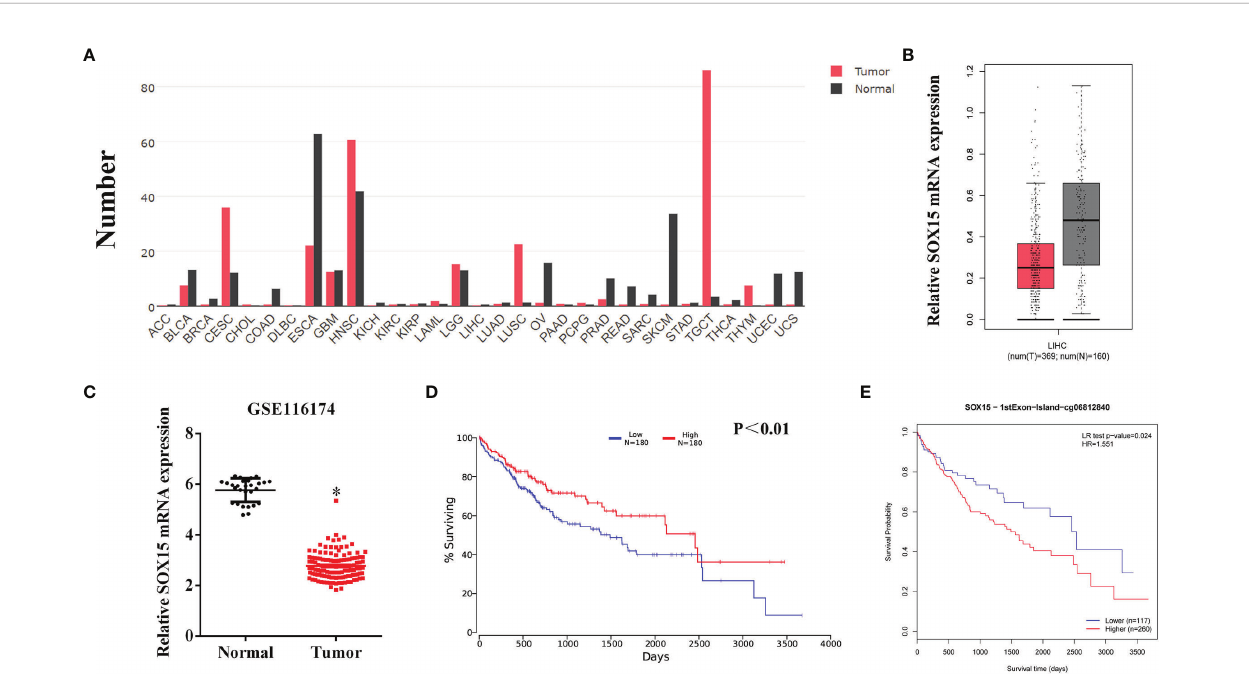
FIGURE 1 | The expression of Sox15 is reduced and positively correlates with prognosis in HCC as analyzed by TCGA and GEO data. (A) Expression pattern of Sox15 in a pan-cancer perspective. (B) Sox15 mRNA levels within the HCC and normal tissues were detected by the TCGA database. (C) Sox15 mRNA expression within HCC and matched, non-carcinoma samples analyzed by GSE116174 data. (D) KM analysis suggested that HCC cases with decreased Sox15 levels suffer a worse OS. p<0.01. (E) KM analysis suggested that HCC cases showing increased Sox15 promoter methylation suffer a worse OS. *p <